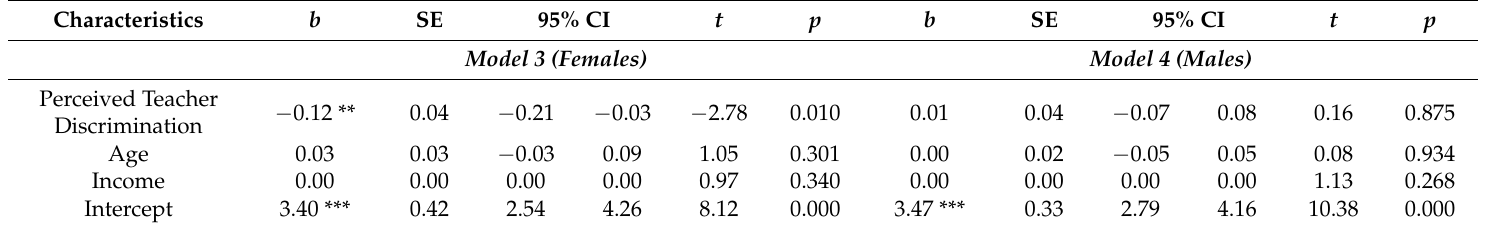
Table 3. Stratified linear regression models in female and male African American